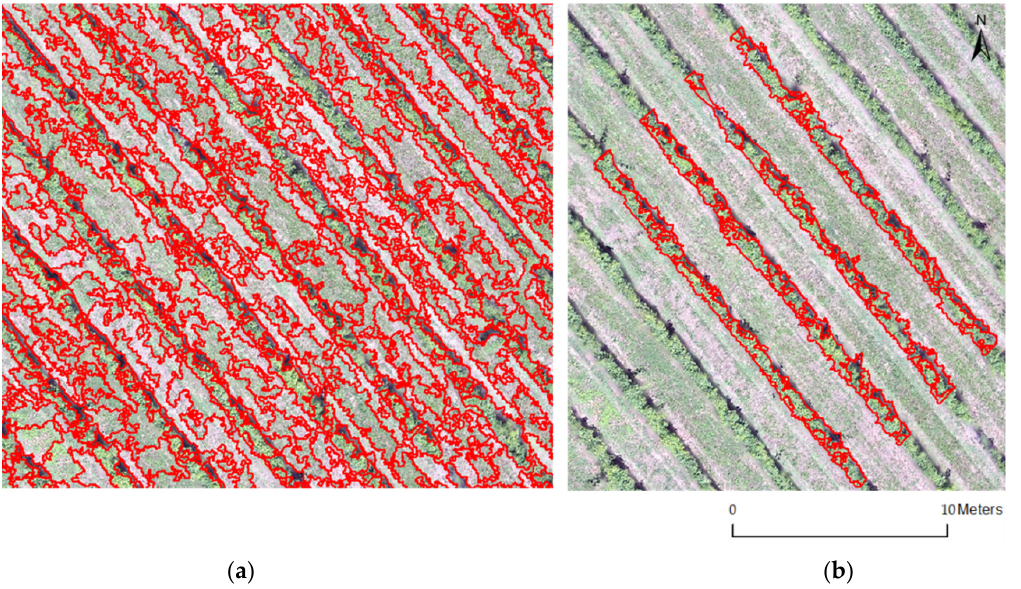
Figure 4. ( a ) Maps with the segmentation image. ( b ) Vine green vegetation considered for calculating canopy temperature.